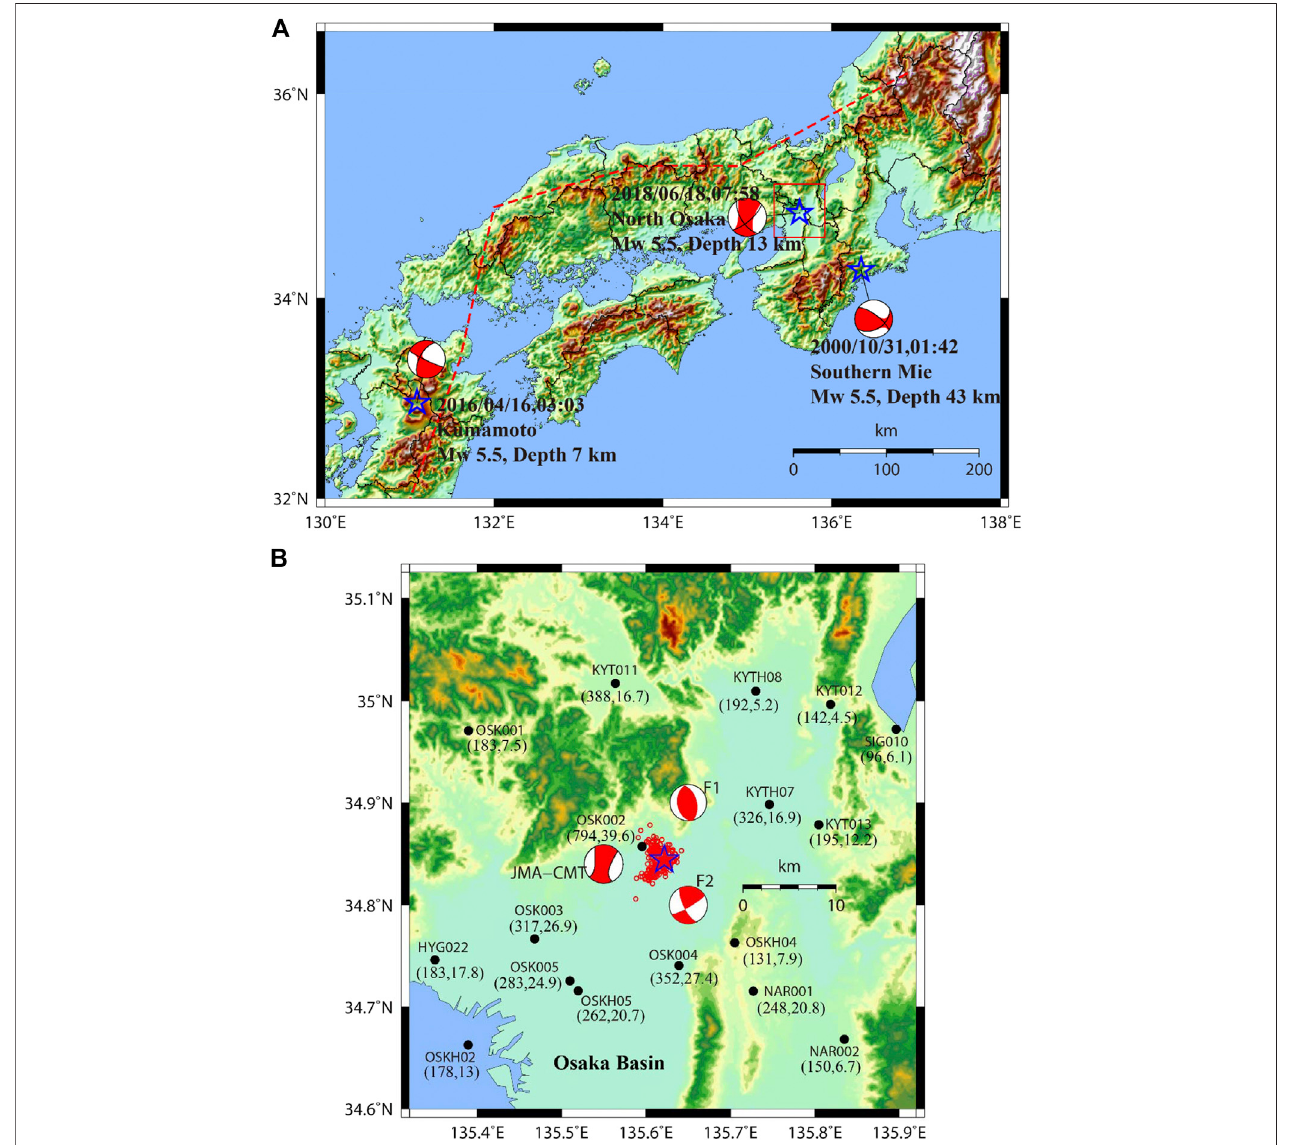
FIGURE 9 | (A) Stars denote epicenters of three Mw 5.5 earthquakes in North Osaka, Southern Mie, and Aso Kumamoto regions, as depicted in the fi gure. The rectangle around the epicenter isthe enlarged area in (B) . The red dashed line represents the volcanic front. The F1 and F2 written near the focal mechanism plots in (B) are the double couple mechanisms proposed by Kato and Ueda (2019) for the two subevents of the North Osaka mainshock. The small red circles denote the aftershockshavingJMAmagnitude > 1recorded within24 h after themainshock. Theblack fi lledcircles represent the strong-motionobservation stations. Thesite codes and the recorded larger PGA and PGV of the two horizontal components are given within parenthesis near the observation stations.